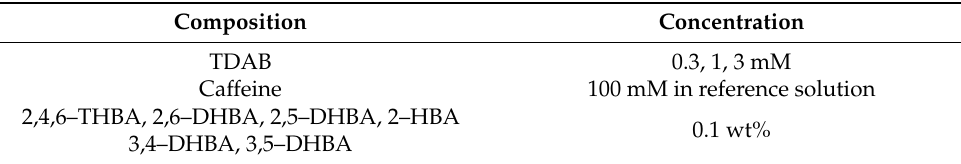
Figure 4. Molecular formulae of HBAs. Table 1. Compositions of lipid/polymer membranes and types of HBA.